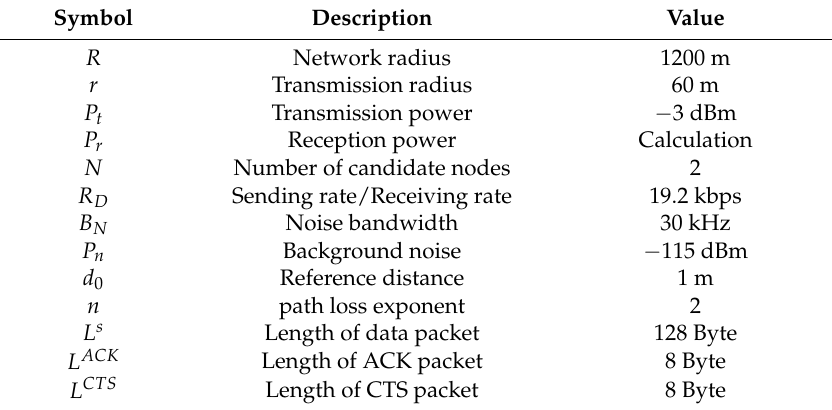
Table 2. Main notations and values adopted in